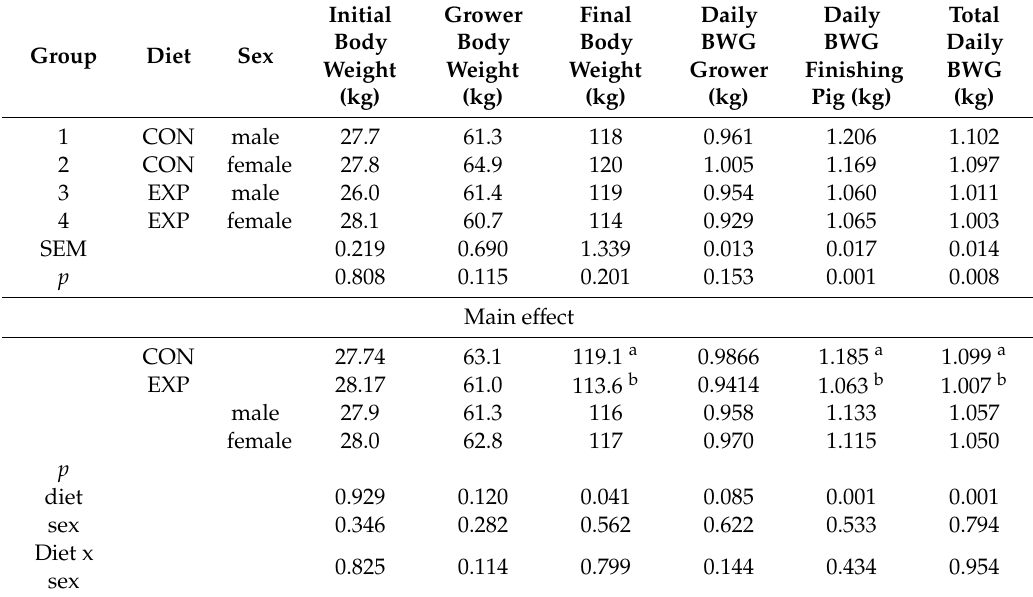
Table 3. Body weight gain at di ff erent weighing